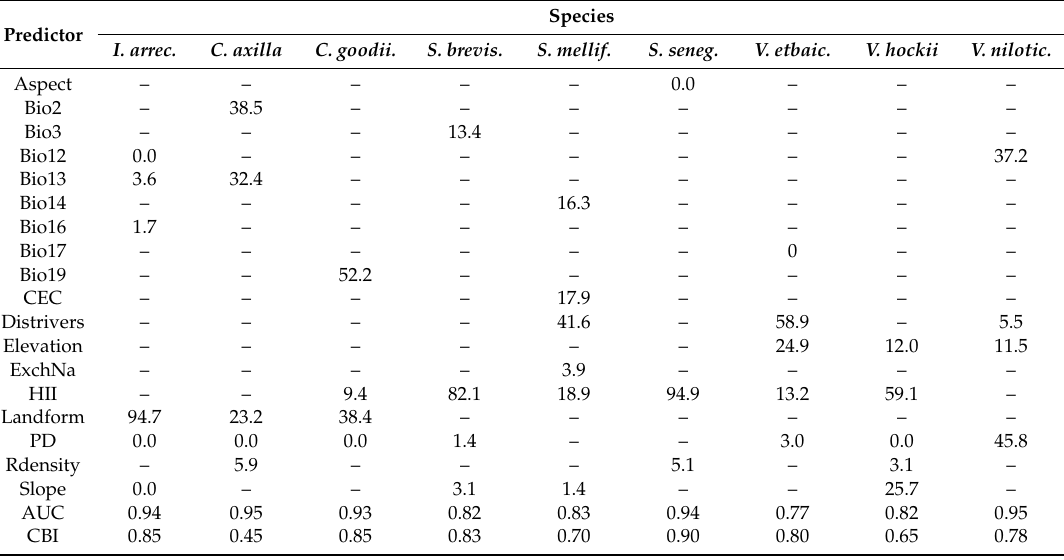
Table 4. Percent permutation importance of predictors per model and test area under receiver operating curve (AUC) and continuous Boyce index (CBI)